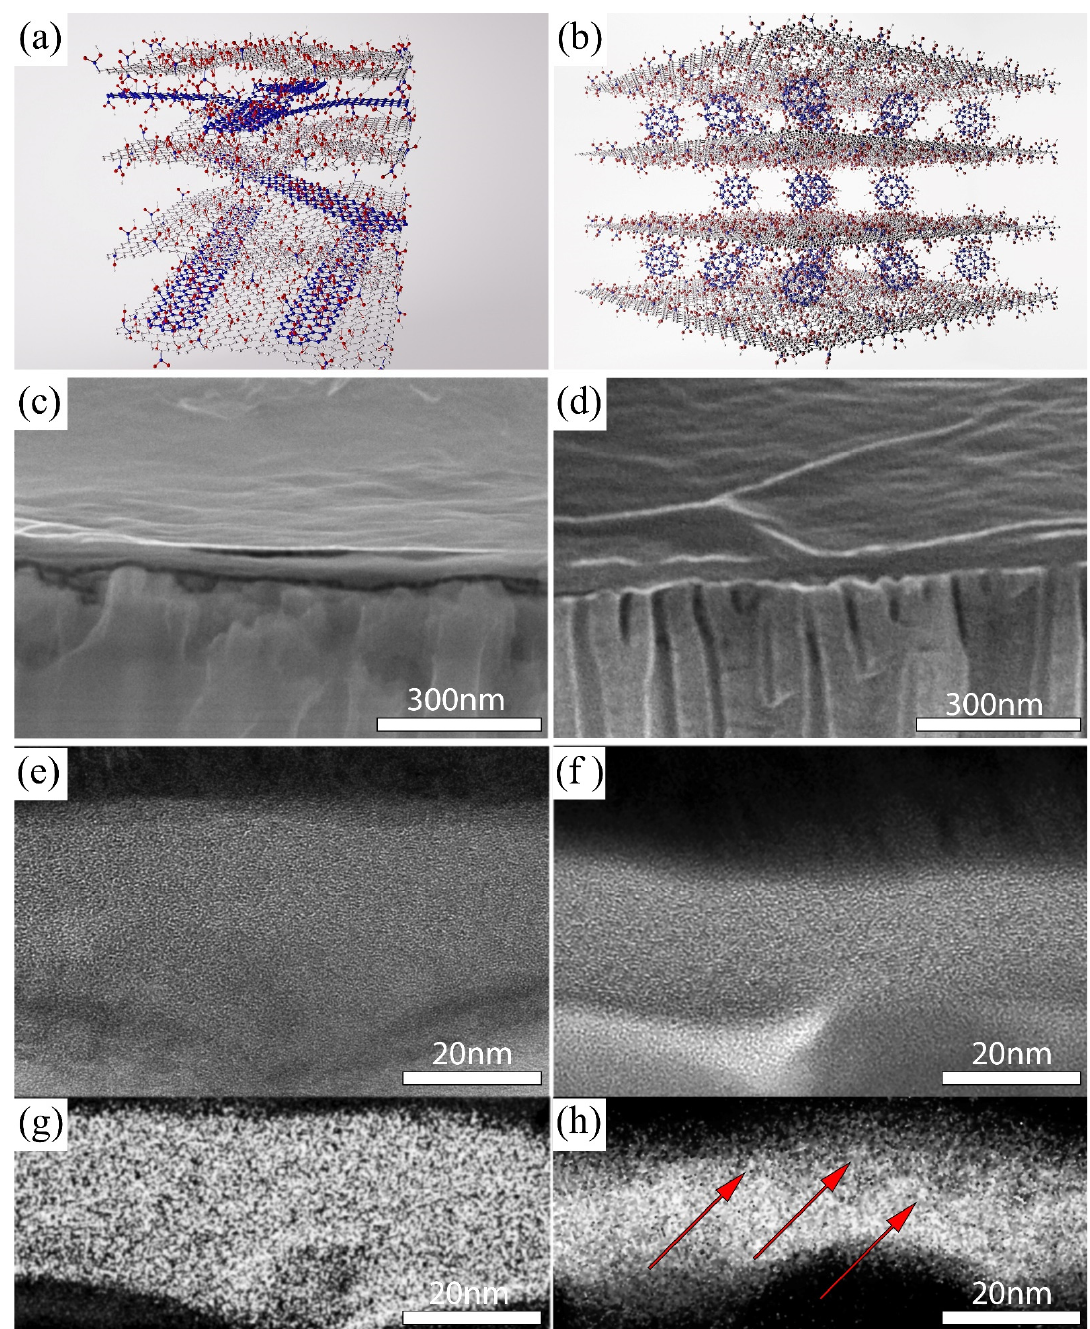
Figure 1. Schematic representation of microstructures of composite membranes: ( a ) CNTGO@MFGO and ( b ) C 60 (OH) 26–32 @MFGO; SEM and TEM micrographs of the cross-sections of the composite membranes: ( c , e ) CNTGO@MFGO and ( d , f ) C 60 (OH) 26–32 @MFGO; energy-filtered carbon K edge images of ( g ) CNTGO@MFGO and ( h ) C 60 (OH) 26–32 @MFGO samples. Due to an increased local atomic density of carbon atoms in fullerenols (>80 atoms/nm 3 ) compared to GO (~50 atoms/nm 3 ), they are seen on C1s EFTEM as brighter spots and inhomogeneities. Red arrows in ( h ) indicate the possible location of fullerenol